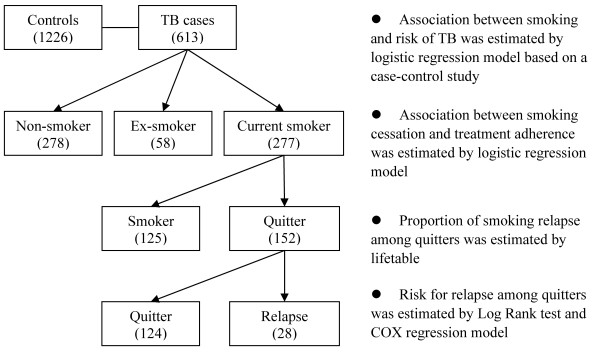
Flow chart of the study design.